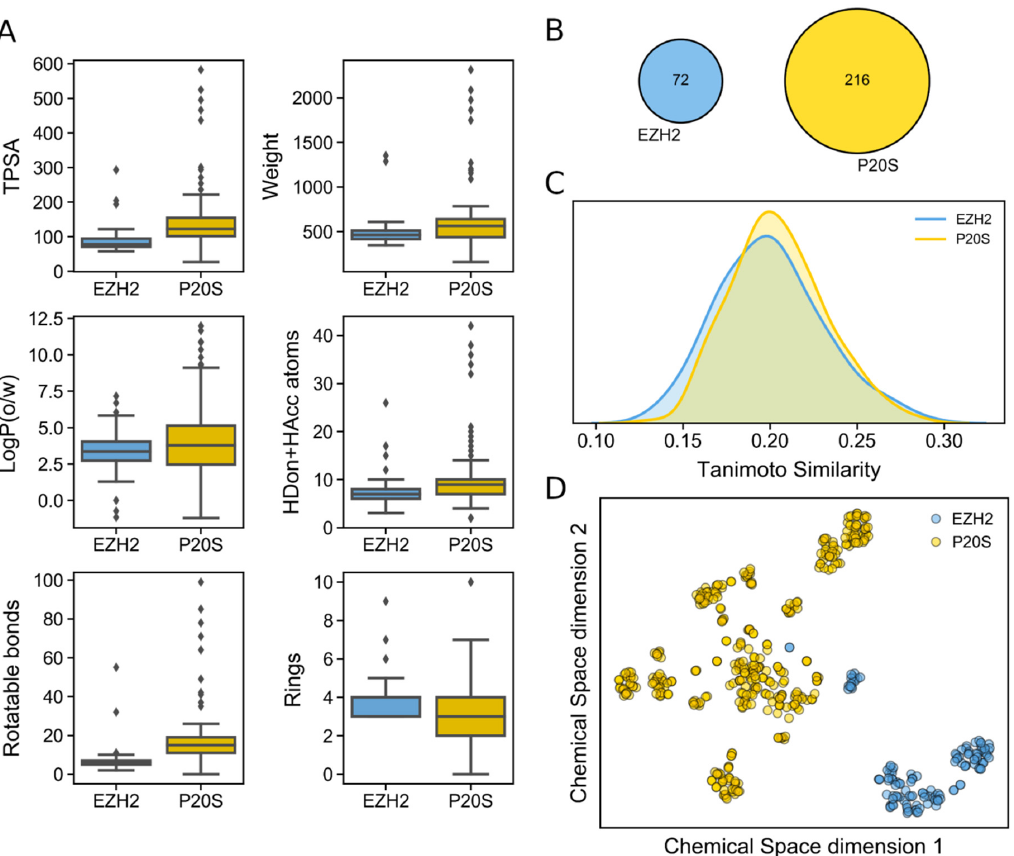
Figure 3. Physicochemical profile and chemical space of EZH2 and P20S inhibitors; ( A ) distribution of six key physicochemical properties calculated in MOE 2019.01; ( B ) overlap in Murcko scaffolds; ( C ) maximum Tanimoto similarity between each EZH2 inhibitor and all P20S inhibitors (yellow) and maximum Tanimoto similarity between each P20S inhibitor and all EZH2 inhibitors (blue); and ( D ) chemical space representation using t-SNE over Morgan Fingerprints.